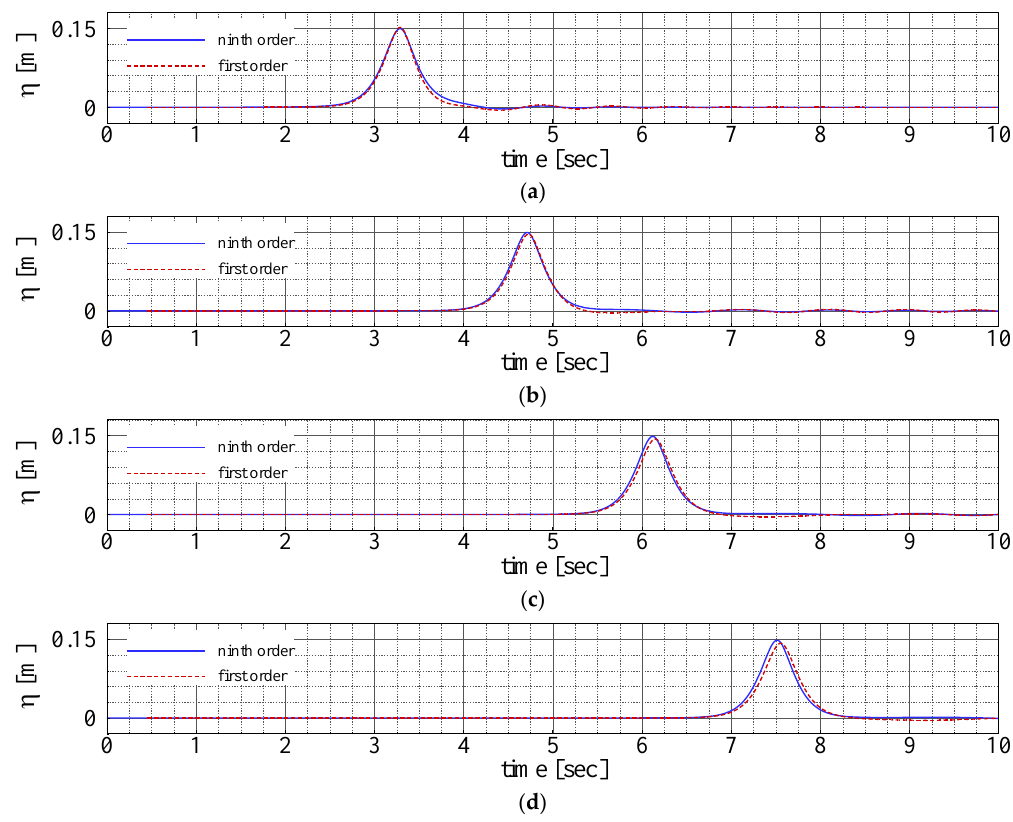
Figure 7. Compare the time traces of water surface evaluation based on the first-order and ninth-order solutions at different positions. ( a ) x = 2 m; ( b ) x = 5 m; ( c ) x = 8 m; (d) x = 11 m.